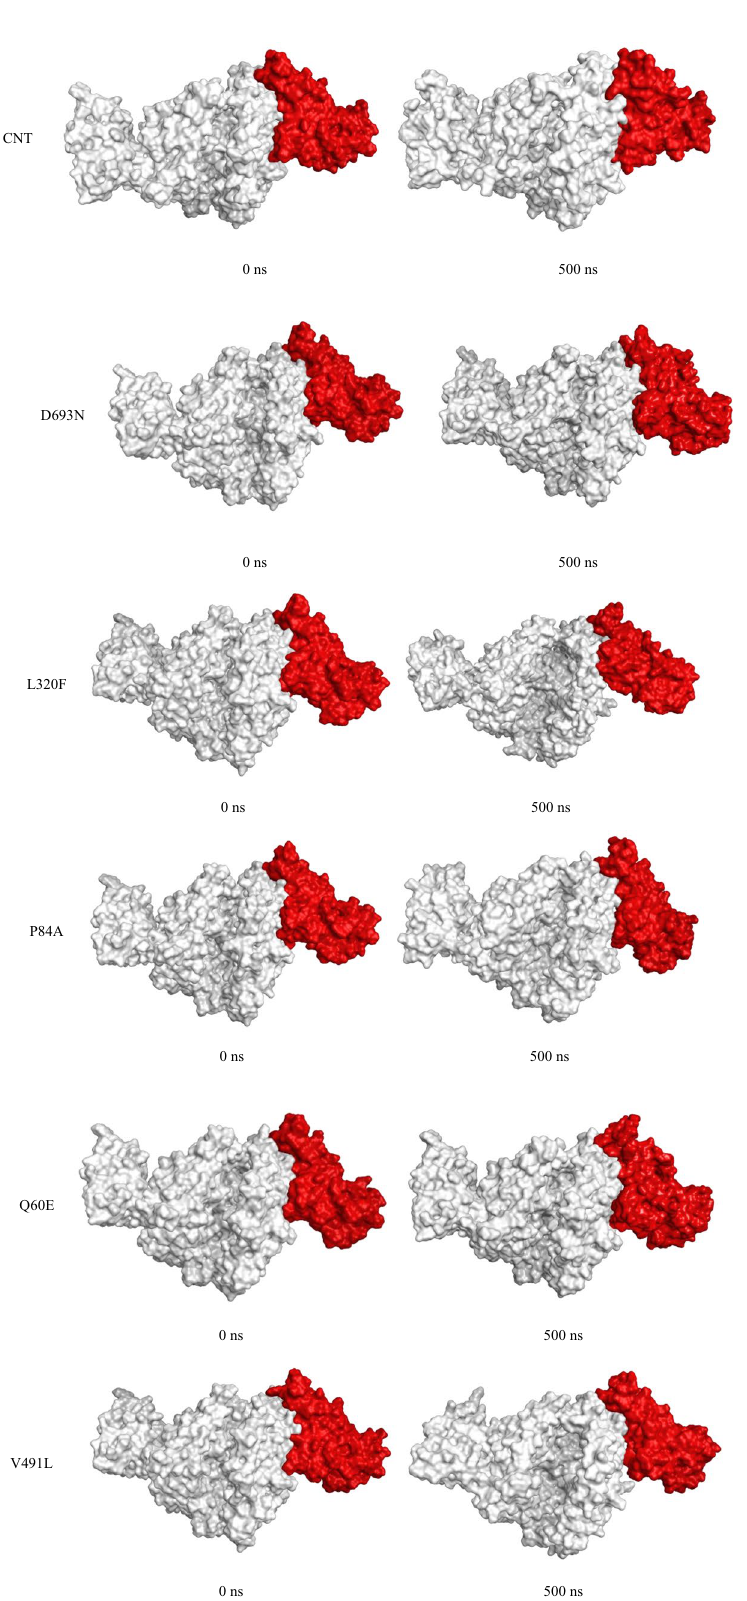
Figure 9. Snapshot of each complex (ACE 2, white; SARS-CoV-2 spike, red) at 0 ns and 500